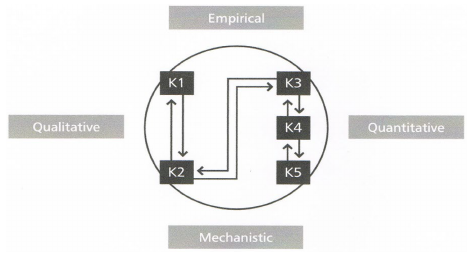
Figure 1. Schematic representation of five types of knowledge, as discussed in the